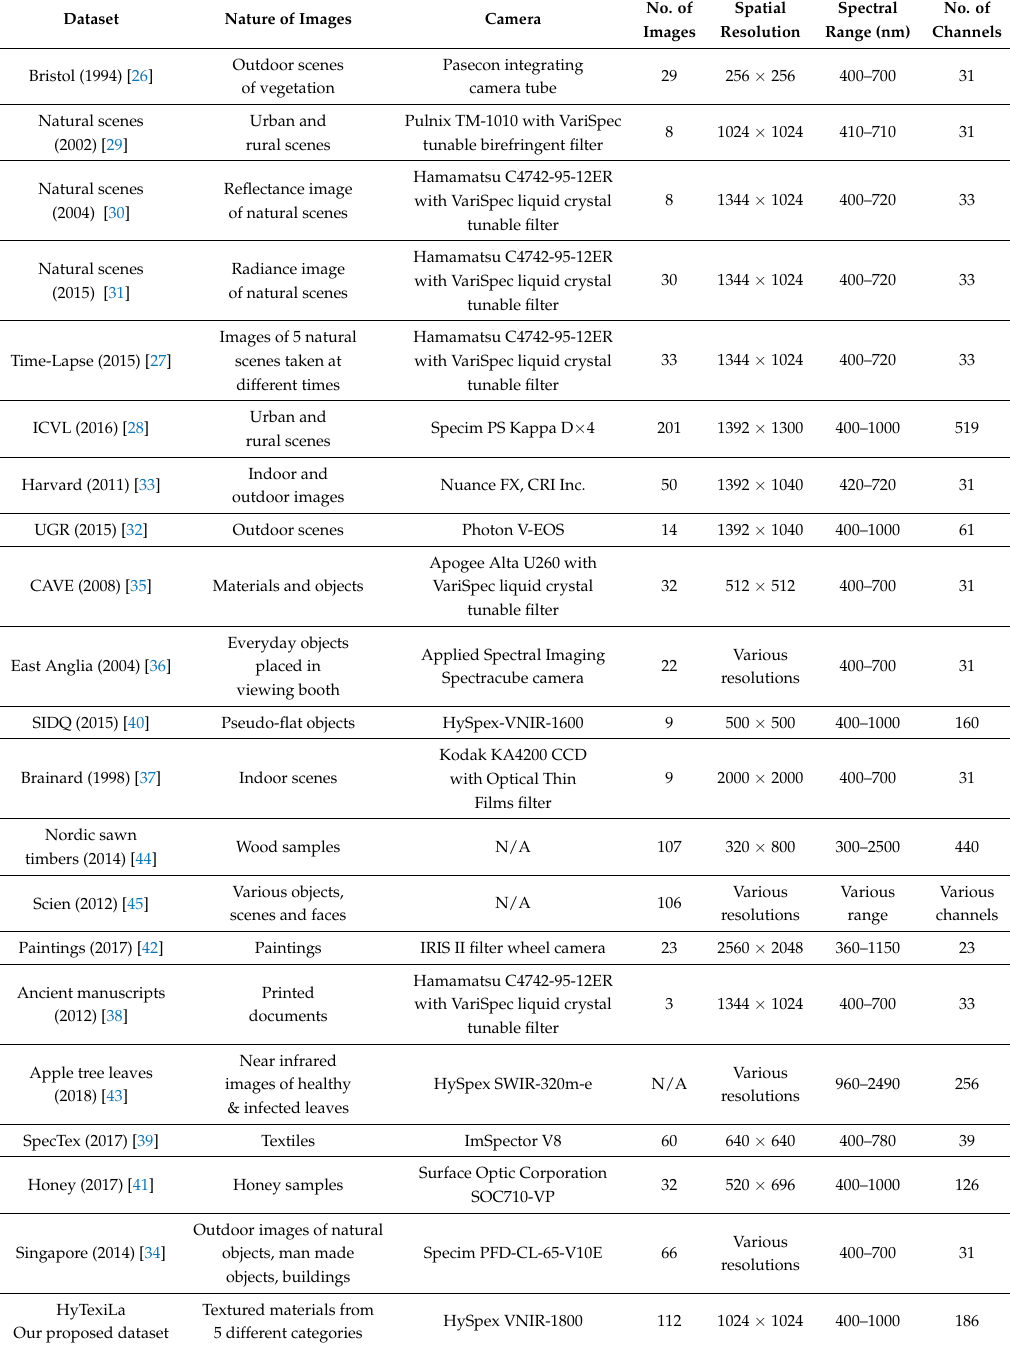
Table 1. Summary of various characteristics of existing and our proposed hyperspectral image dataset (N/A means information not available from the dataset